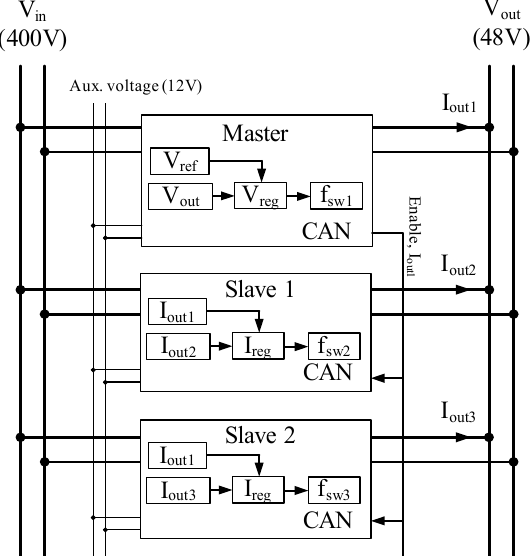
Figure 10. Dynamic load change from 100% to 20% of P OUT for frequency follower control strategy.